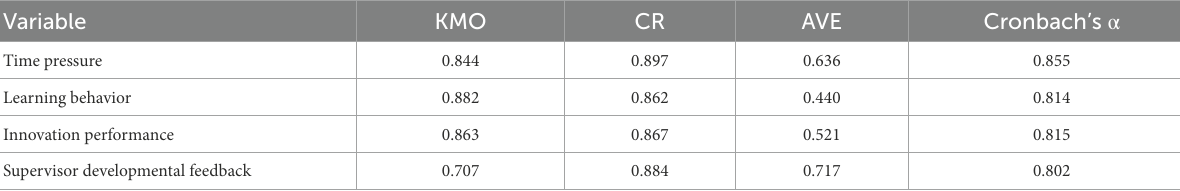
TABLE 3 Reliability and validity analysis results in Study 2.